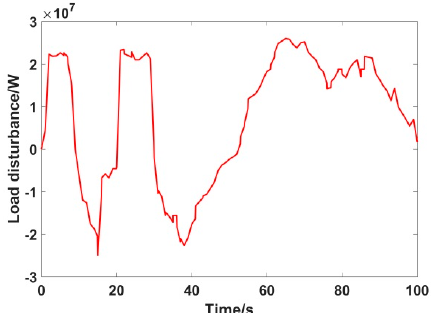
Figure 17. Continuous load disturbance. Processes 2020 , 8 , x FOR PEER REVIEW